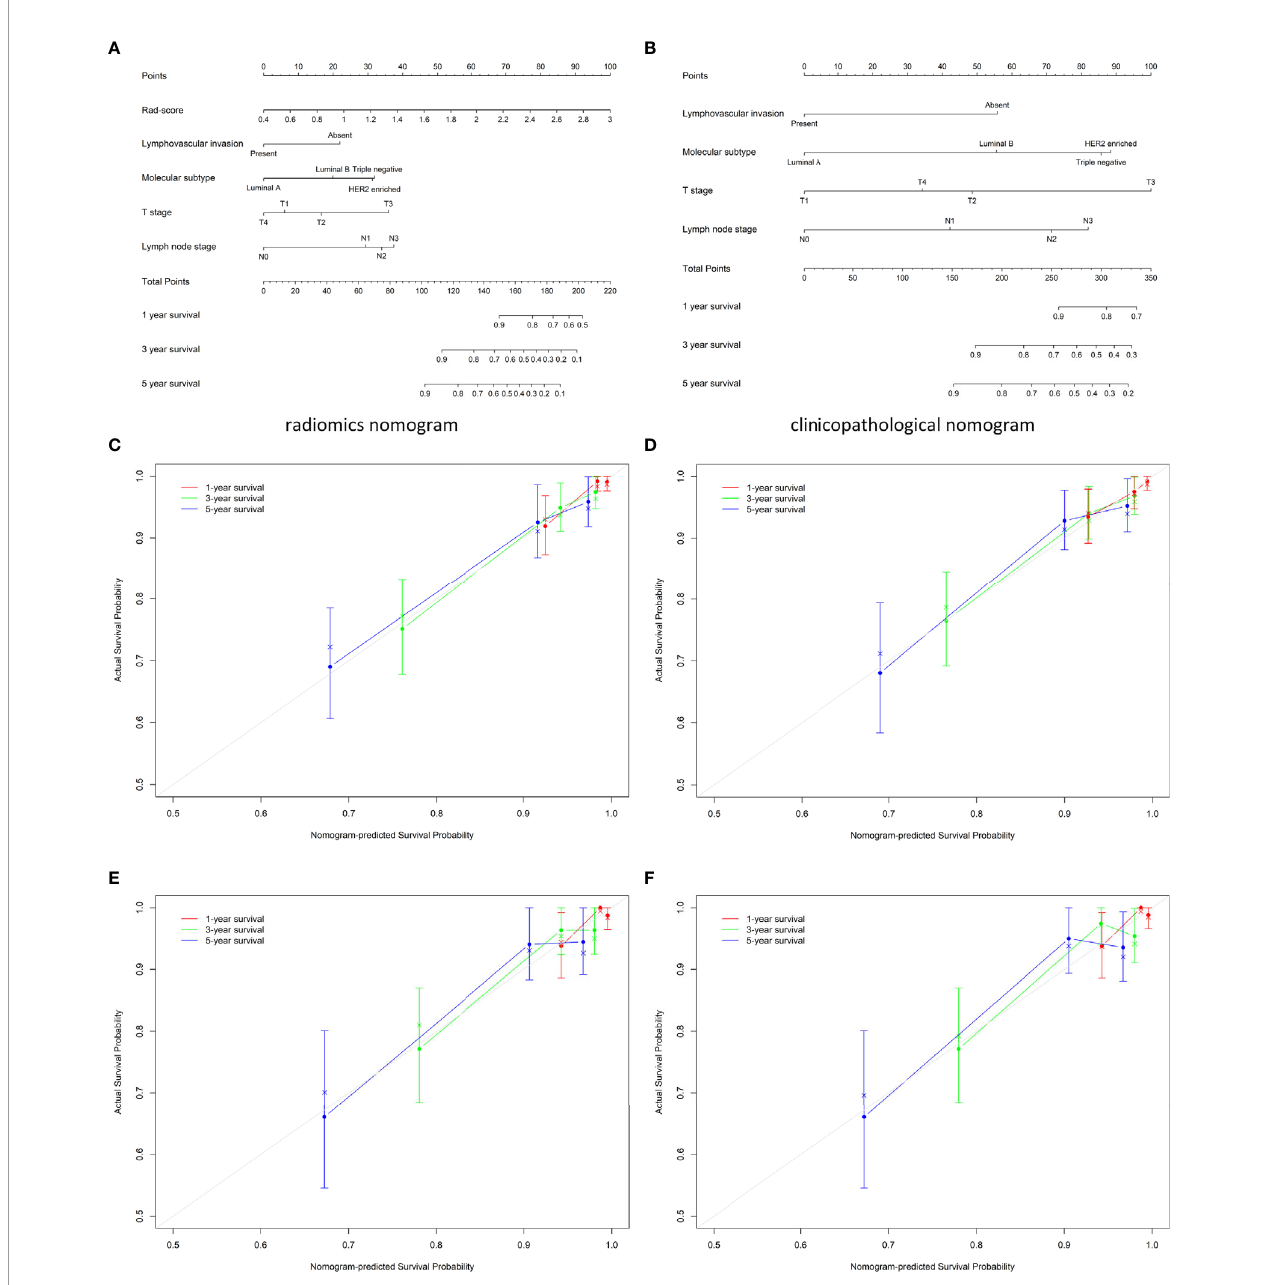
FIGURE 3 | The developed radiomics nomogram (A) and clinicopathological nomogram (B) for DFS prediction in patients with invasive breast cancer, along with the calibration curves of these nomograms. The patient ’ s Rad-score is located on the Rad-score axis. To determine the number of points toward the probability of DFS the patient receives for her Rad-score, a line was drawn straight upward to the point axis, and this process was repeated for each variable. The points achieved for each of the risk factors was then summed. The fi nal sum is located on the total point axis. To fi nd the patient ’ s probability of DFS, a line was drawn straight down. Calibration curves of the radiomics nomogram in the training (C) and validation (E) cohorts, and those of the clinicopathological nomogram in the training (D) and validation (F) cohorts show the calibration of each model in terms of the agreement between the estimated and observed at 1-, 3-, and 5-year outcomes. Nomogram-estimated probability is plotted on the x-axis, and the actual survival probability is plotted on the y-axis. The diagonal gray line represents a perfect estimation by an ideal model, in which the estimated outcome perfectly corresponds to the actual outcome. The colored line represents the nomogram ’ s performance, a closer alignment of which with the diagonal dotted line represents a better estimation. DFS, disease-free survival; Rad-score, radiomics